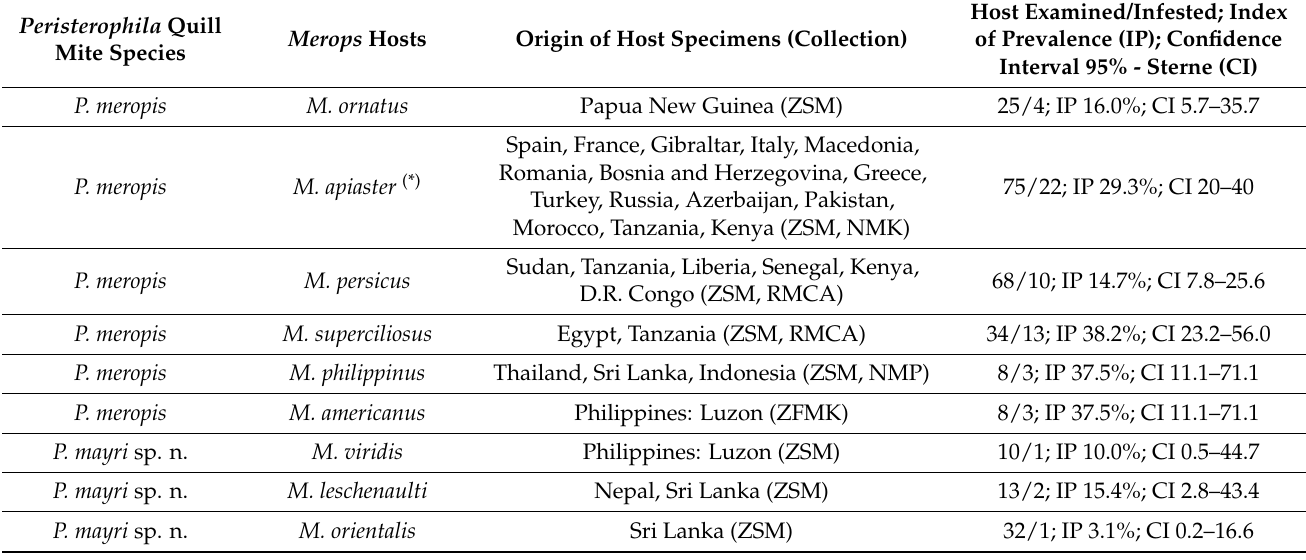
Table 1. Peristerophila quill mites found on examined Merops host species and index of prevalence; (*) data from Skoracki et al.